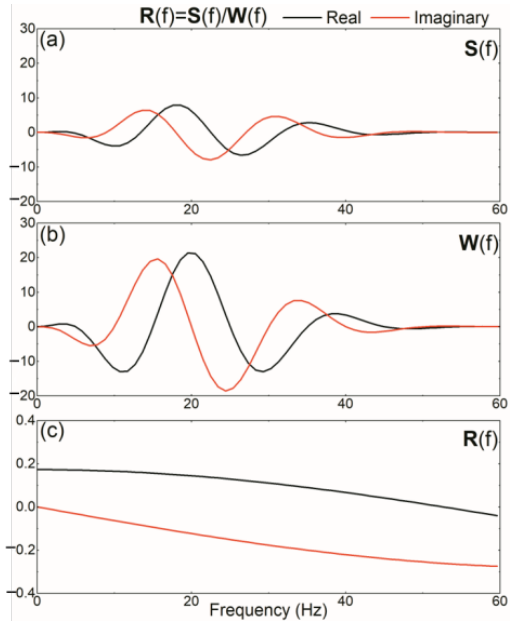
Figure 6. Example of Model 3 at normal incidence for R(θ,f) = S(θ,f)/W(θ,f): ( a ) real and imaginary components of seismic records; ( b ) real and imaginary components of Ricker wavelet; ( c ) real and imaginary components of thin-bed P-wave reflection coefficients.